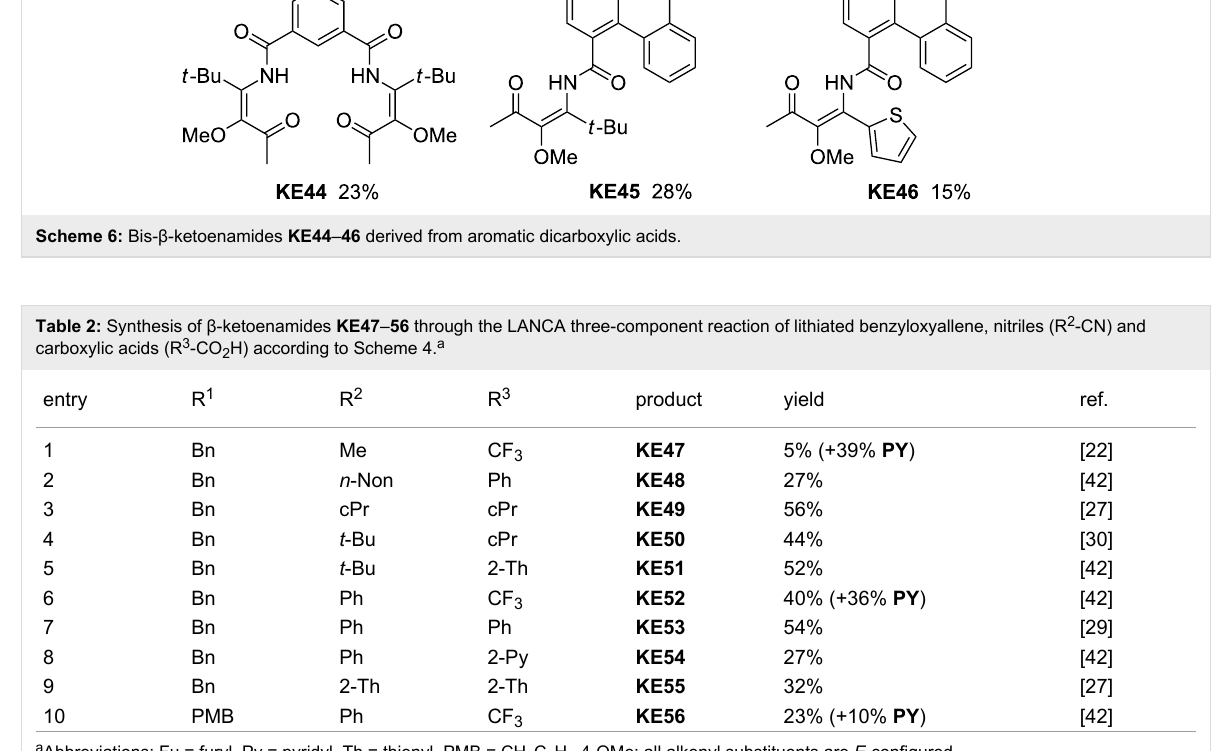
differences to the observations with methoxyallene. The β